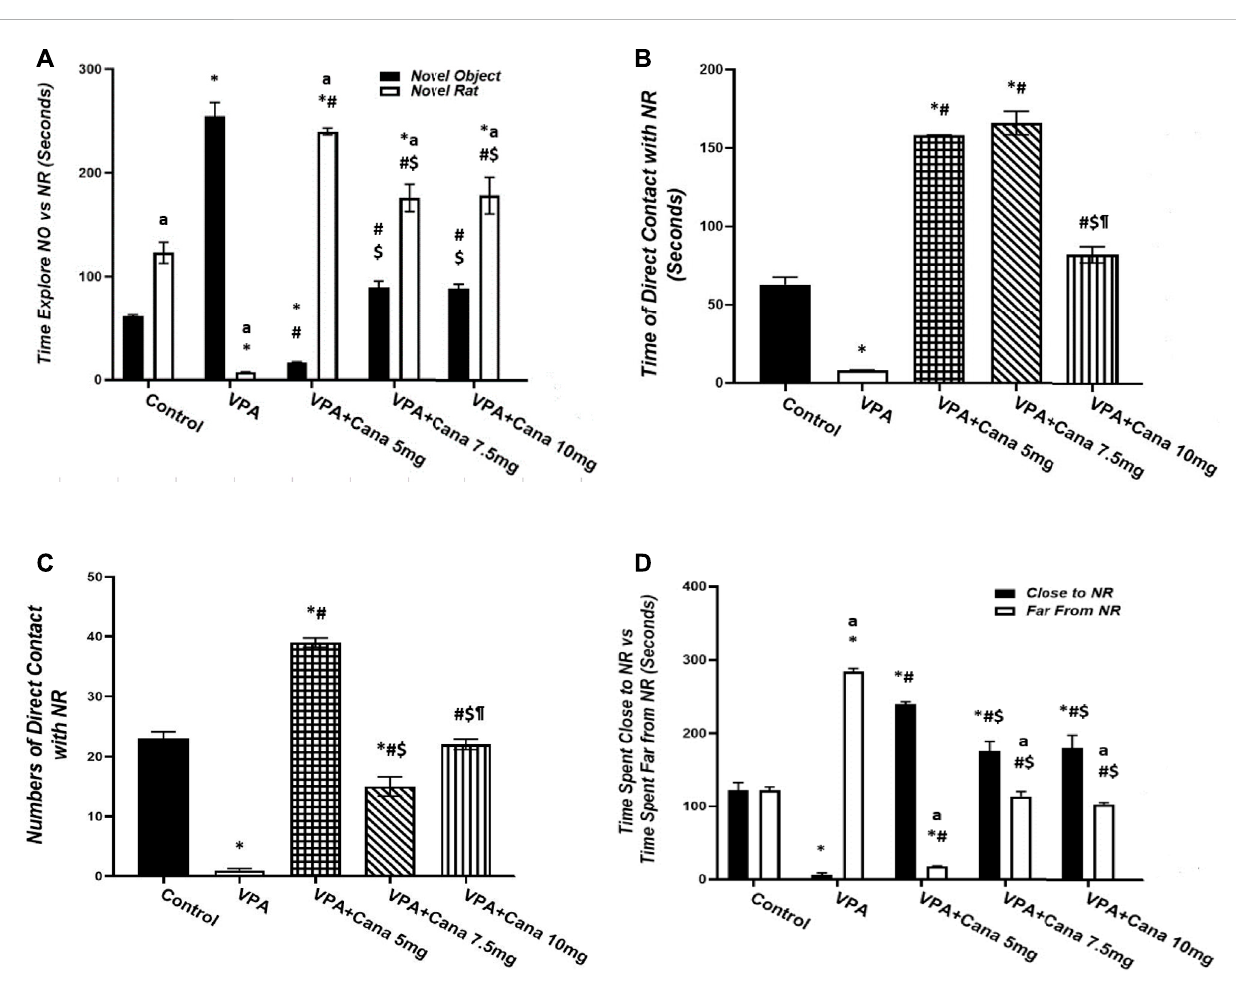
FIGURE 1 Effect of canagli fl ozin (5 mg/kg, 7.5 mg/kg, and 10 mg/kg) on sociability test; time explore NO versus NR (A) , time of direct contact with NR (B) , number of times of direct contact with NR (C) , and time spent close to NR versus time spent far from NR (D) in VPA-induced autism in rats. VPA, valproic acid; Cana, canagli fl ozin; NO, novel object; NR, novel rat. All values are expressed as mean ± S.E.M. Results represented in Figures 1B, C were analyzed using one-way ANOVA, followedby Tukey ’ s post hoc multiple comparisons test. Results represented in Figures 1A, D were analyzed using two-way ANOVA, followed by Tukey ’ s post hoc multiple comparisons test. *Compared to the corresponding control group at p < 0.05, # compared to the correspondingVPAgroupat p < 0.05, $ comparedtothecorrespondingVPA+Cana(5 mg/kg)groupat p < 0.05, ¶ comparedtothecorrespondingVPA+ Cana (7.5 mg/kg) group, a comparedto time exploring NO within thesame experimental groups (A) , a comparedto time close to novel rat (D) at p < 0.05, n = 8, for all groups except for the control group, n =